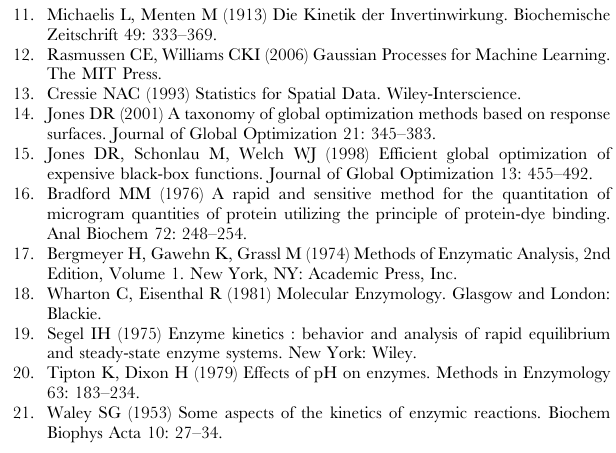
Figure S1 Influence of pH and KCl concentration in reaction buffer on spontaneous NADH oxidation. Each dot corresponds to a measurement conducted with one of 48 conditions from the space filling design of the PYK-LDH coupled assay. In all